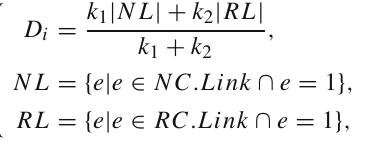
tournament selection strategy. An alternative population Q (cid:5) t consisting of M new individuals is immediately produced by performing the novel crossover and mutation operations ,wherethe (depictedinthenextsection)onthematingpool P (cid:5) t value of M is much greater than N . Then, for each individual Q i in Q (cid:5) , the architecture entropy of P t before and after Q i is t inserted into P t is calculated, and the change which is taken as the sampling metric is assigned to Q i . Subsequently, the proposed sampling strategy based on architecture entropy is utilized select top N offspring individuals with a wide range of diversity to produce offspring population Q t . In environmentselection, P t and Q t aremergedintoacombined population with the size of 2 N , and all individuals are trained to update the fitness values. Followingly, N individuals are selected as the parent population of the next generation P t + 1 according to the non-dominated ranking criteria. The above steps will repeat until the termination condition is